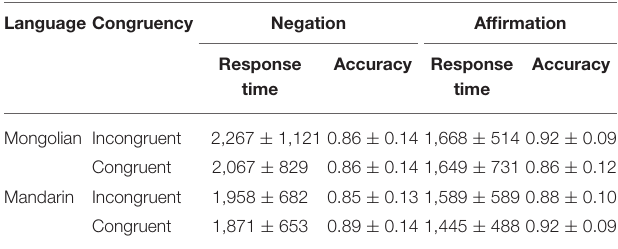
TABLE 4 | Means and standard deviations of response time (ms) and accuracy rate (%) at 1,500